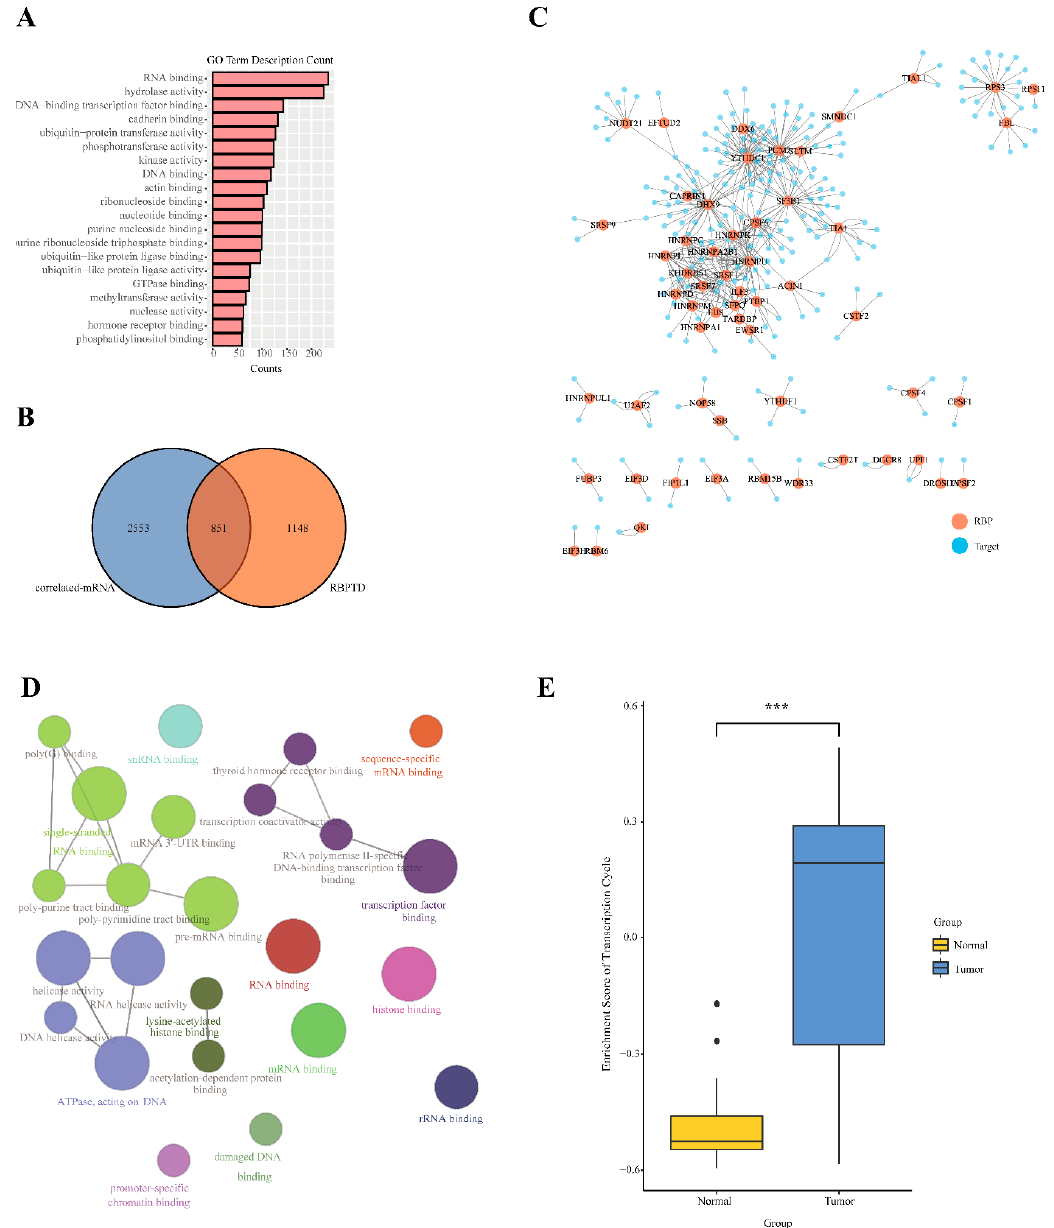
Figure 4. The RBP-regulated network and transcription cycle pathway of U1-lncRNAs correlated mRNAs. ( A ) GO term count of U1-lncRNAs correlated mRNAs. ( B ) Venn diagram illustrating the overlapped genes in U1-lncRNAs correlated mRNAs and RBPTD database. ( C ) RBP-target network constructed by the top 500 pairs of RBP-target in U1-lncRNAs correlated mRNAs. ( D ) Functional annotation of genes in the top 500 pairs by ClueGO. ( E ) The enrichment score of transcription cycle of tumor and normal samples in TCGA-LIHC dataset. T-test was used to compare enrichment scores of tumor and normal samples. Significance level: *** p < 0.001.